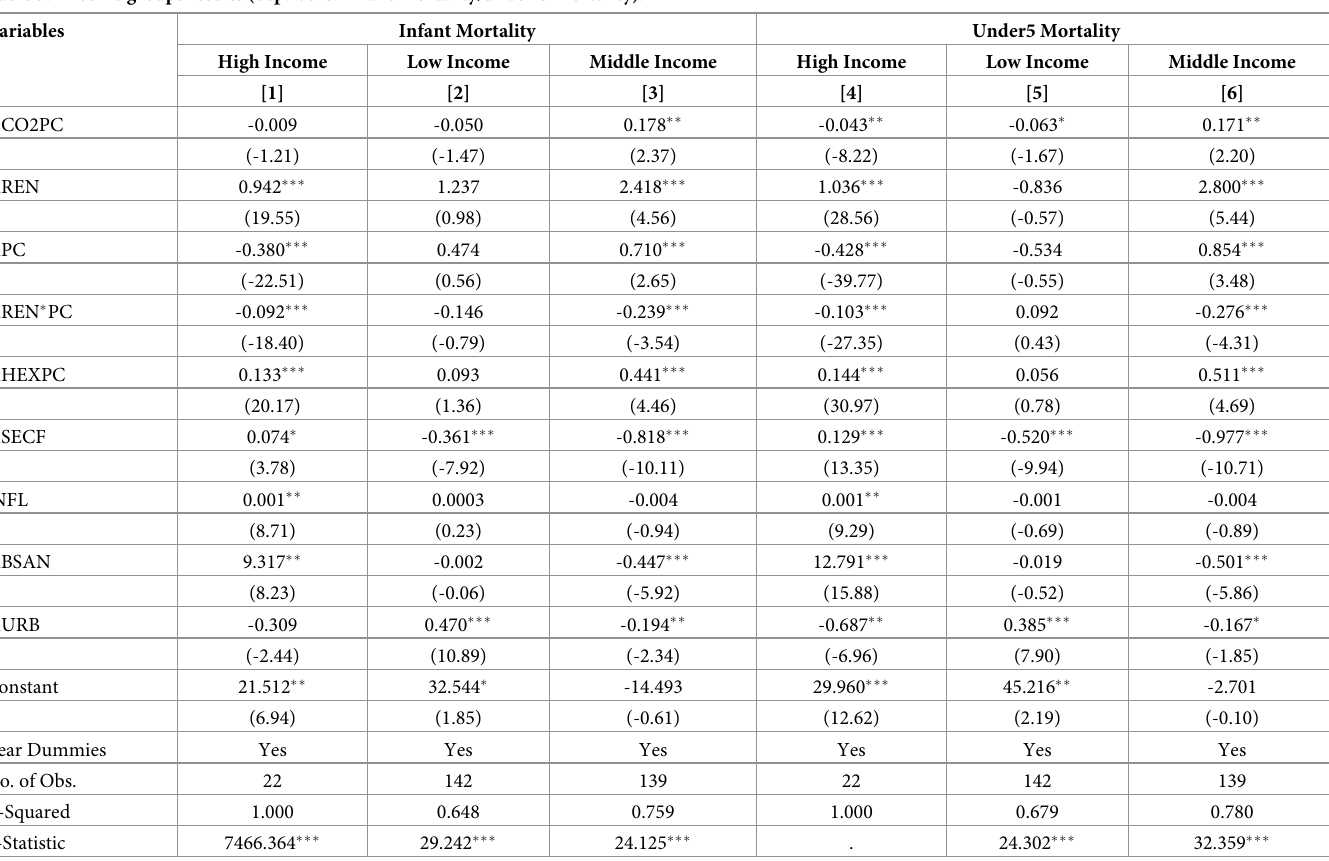
Table 5. Income groups results (dep. Vars: Infant mortality/under-5